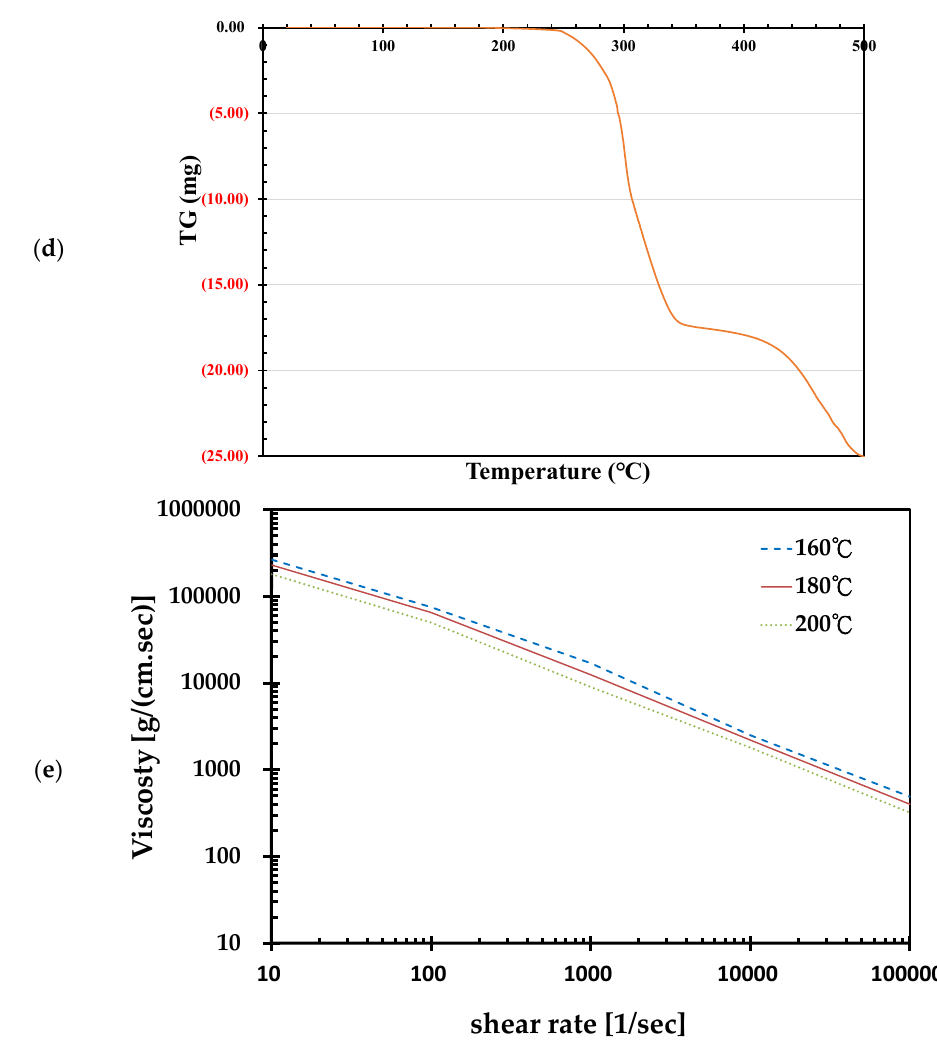
Figure 1. Rheological properties of Suspension S-60 PVC, Formosa Plastic Co. ( a ) DSC heating curves; ( b ) P-v-T curves; ( c ) specific heat curve; ( d ) thermo-gravimetric analysis results; ( e ) viscosity. Below 110 °C, the thermal conductivity of PVC is 6.254 × 10 − 4 (W/cm °C), while from 110 to 170 °C, the function of thermal conductivity of melt PVC is 5.698 + 0.005055T (W/cm °C). The thermal conductivity of melt PVC is 8.024 × 10 − 4 (W/cm °C) once the temperature